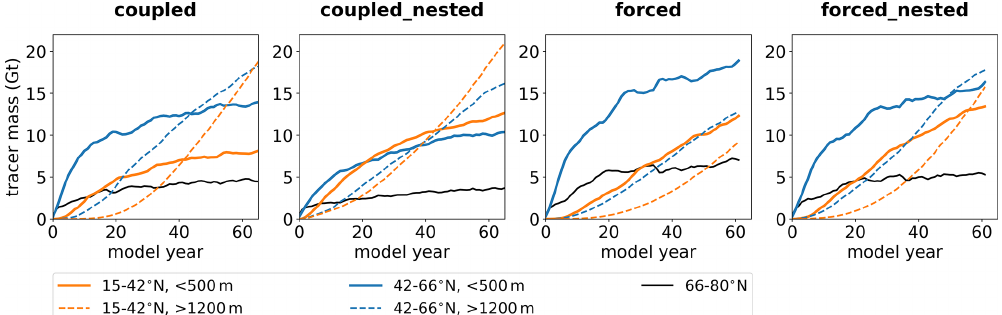
Figure 12. Total meltwater tracer mass for selected regions of the North Atlantic integrated over the entire basin width for the upper 500m (solid lines) and below 1200m (dashed lines). Blue lines depict the tracer mass in the subpolar gyre between 42 and 66 ◦ N, while orange lines depict the tracer mass in the subtropical gyre (15–42 ◦ N). The black lines combine Nordic Seas and Baffin Bay tracer mass inventories, which are approximately of the same magnitude.